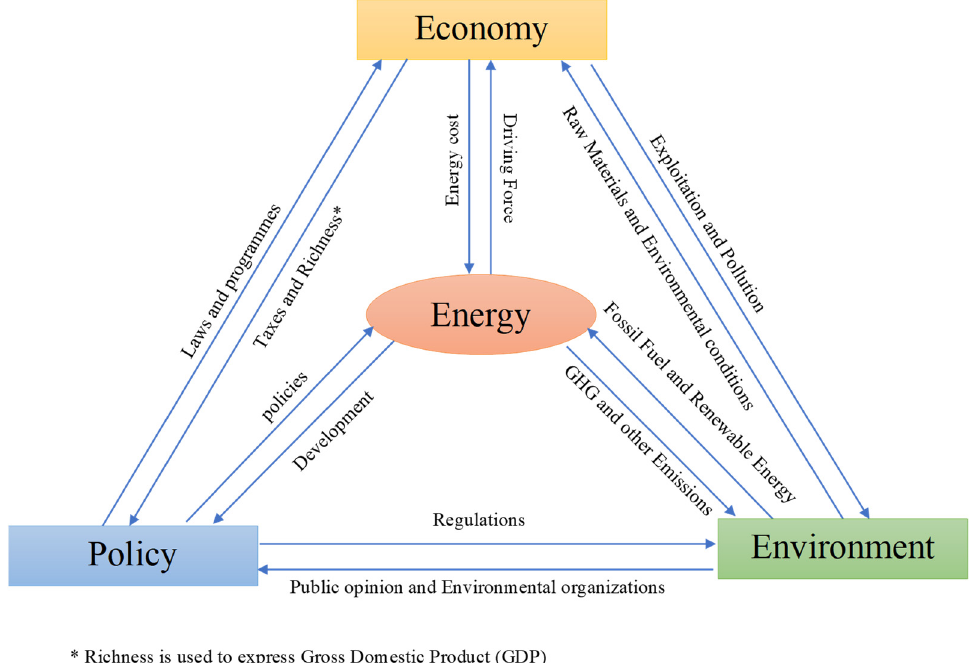
Figure 1. Fields influencing energy development.